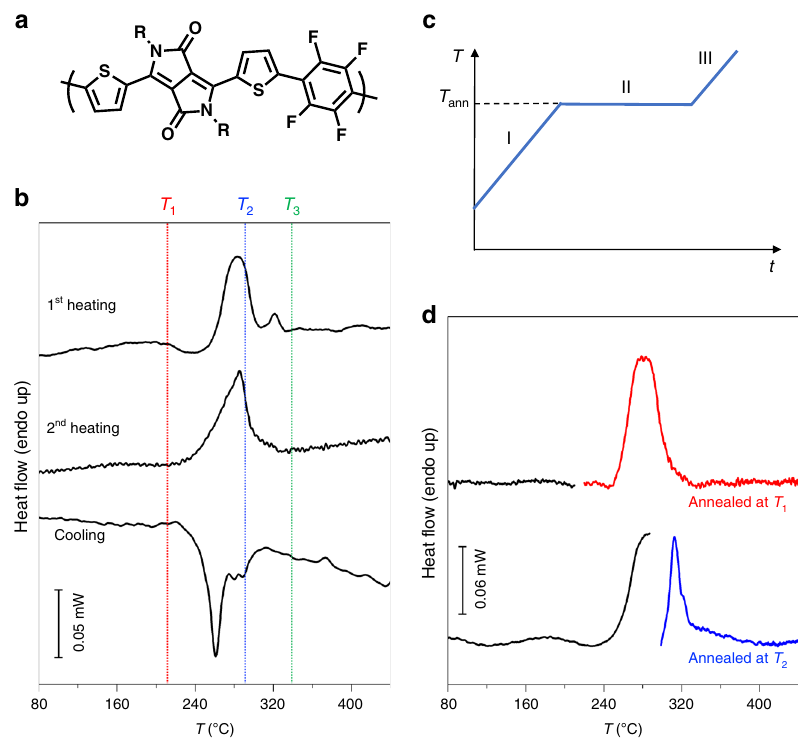
Fig. 1 Fast scanning calorimetry data. a Molecular structure of PThDPPThF4. R = 2-octyldodecyl. b Fast scanning calorimetry (FSC) 1st heating, 2nd heating and cooling traces for a spin-cast thin fi lm of PThDPPThF4 with M n = 14 kg mol − 1 . The three temperatures T 1 , T 2 , and T 3 are below, within and above the melting endotherm, respectively and used throughout this study. c Temperature program of isothermal annealing: stage I is the heating ramp from 30 °C to the annealing temperature ( T ann ) at a rate of 2000 °C s − 1 , stage II is a 5 min annealing period at T ann , and stage III corresponds to a scan from T ann to 450 °C at 2000 °C s − 1 . d Heating traces using the isothermal annealing protocol shown in c with T 1 = 210 °C and T 2 = 287 °C. The black lines correspond to the calorimetric signal recorded as heating as spun samples up to the annealing temperatures, i.e. segment I in c . The red and the blue lines correspond to the heating scans recorded immediately after the 5-min-annealing steps at T 1 and T 2 , respectively, i.e. segment III in